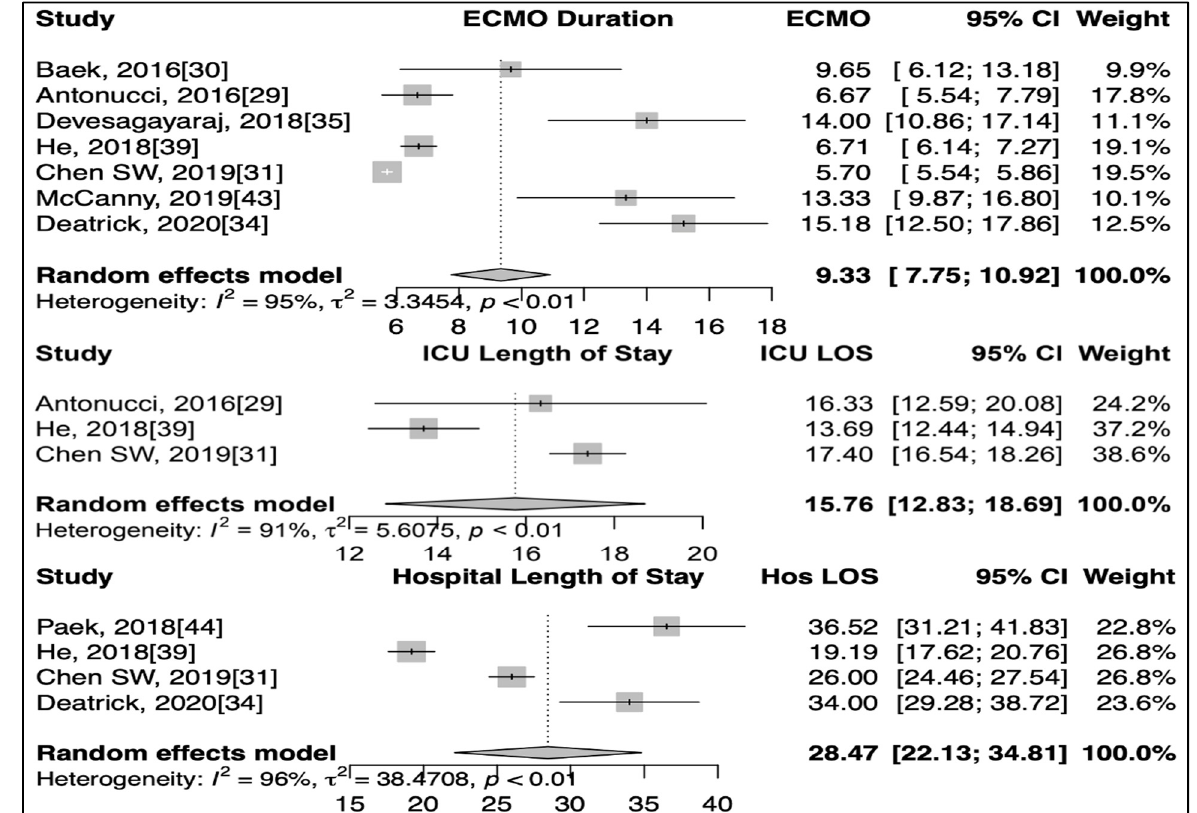
Figure 3. Forest plot showing mean ECMO (extra-corporeal membrane oxygenation) duration, ICU (Intensive care unit) and Hospital Length of Stay (LOS) of patients who received combined therapies.